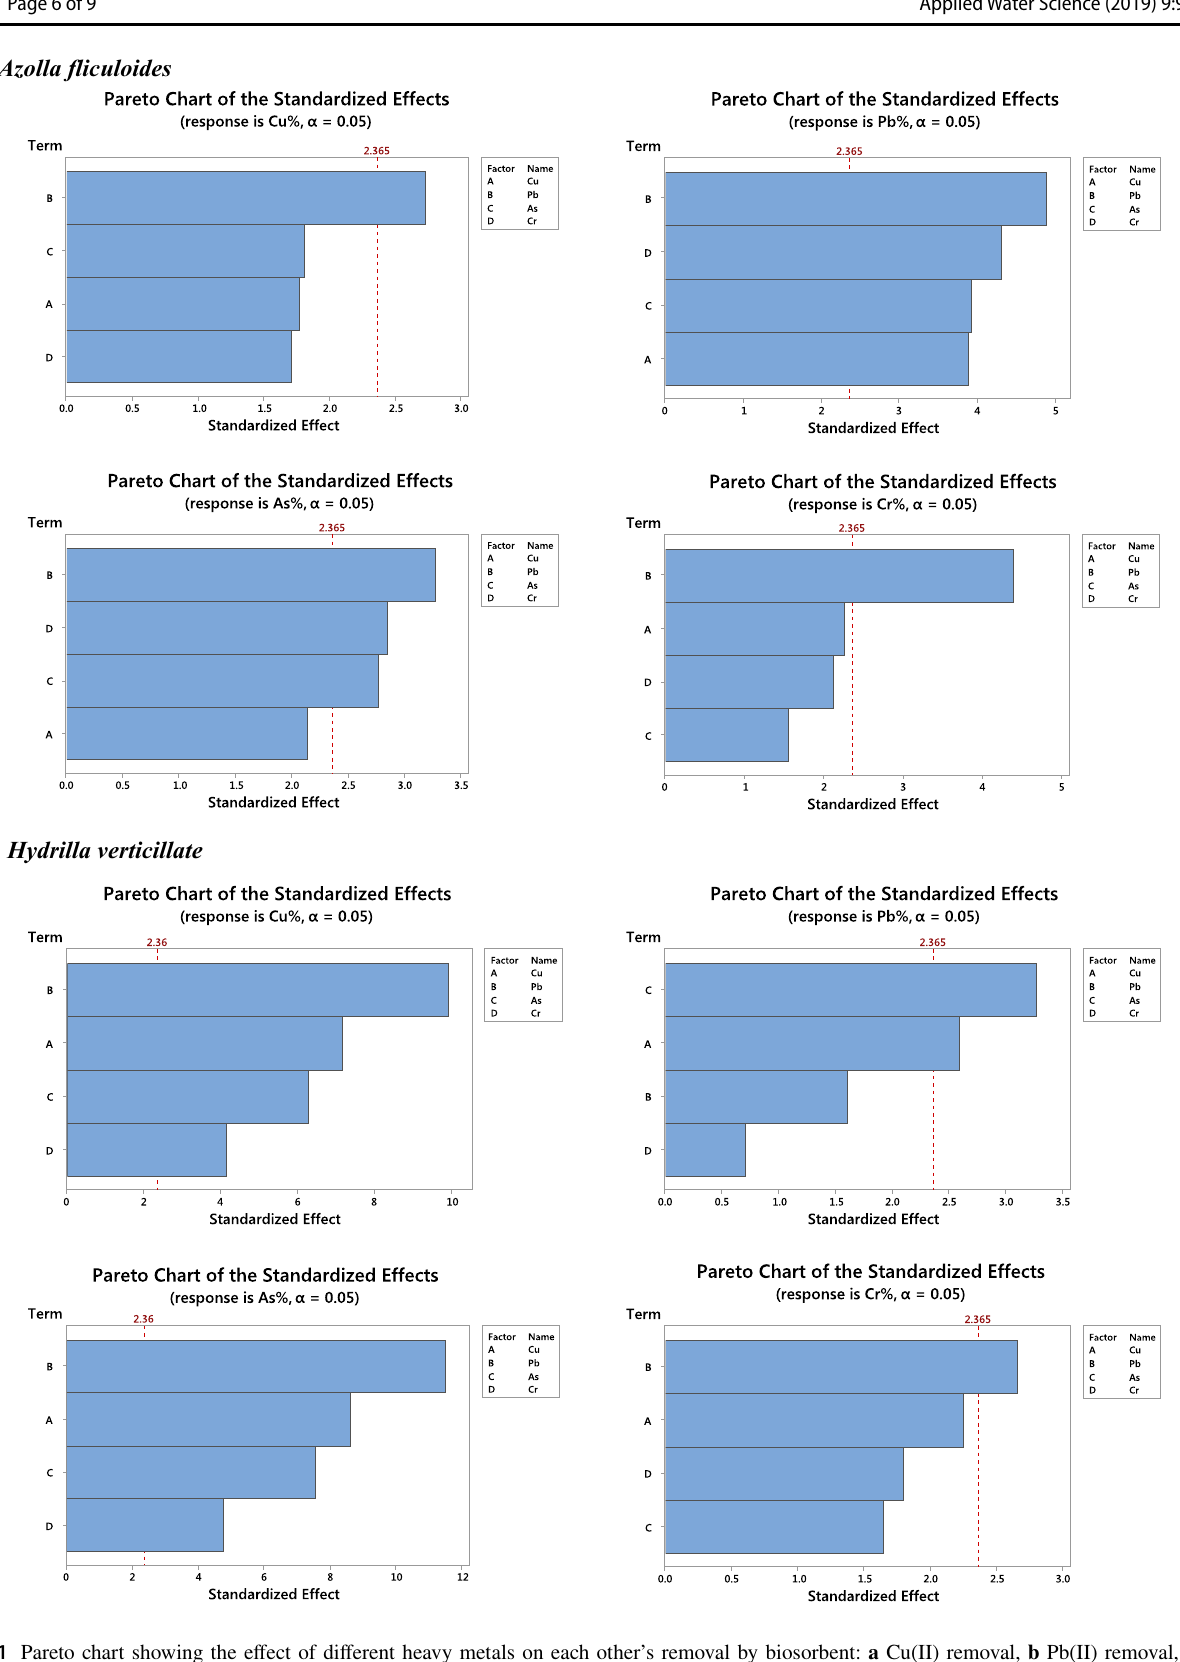
Fig. 1 Pareto chart showing the effect of different heavy metals on each other’s removal by biosorbent: a Cu(II) removal, b Pb(II) removal, c As(III) removal and d Cr(VI) removal (vertical line shows significant cutoff at P value less than